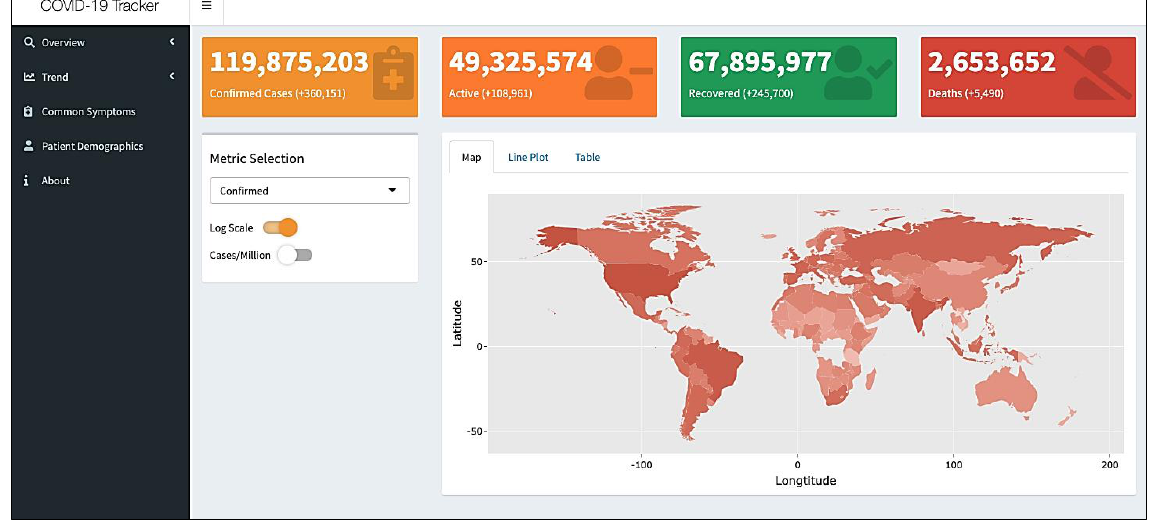
Figure 1. Overview Page (Website Landing Page)